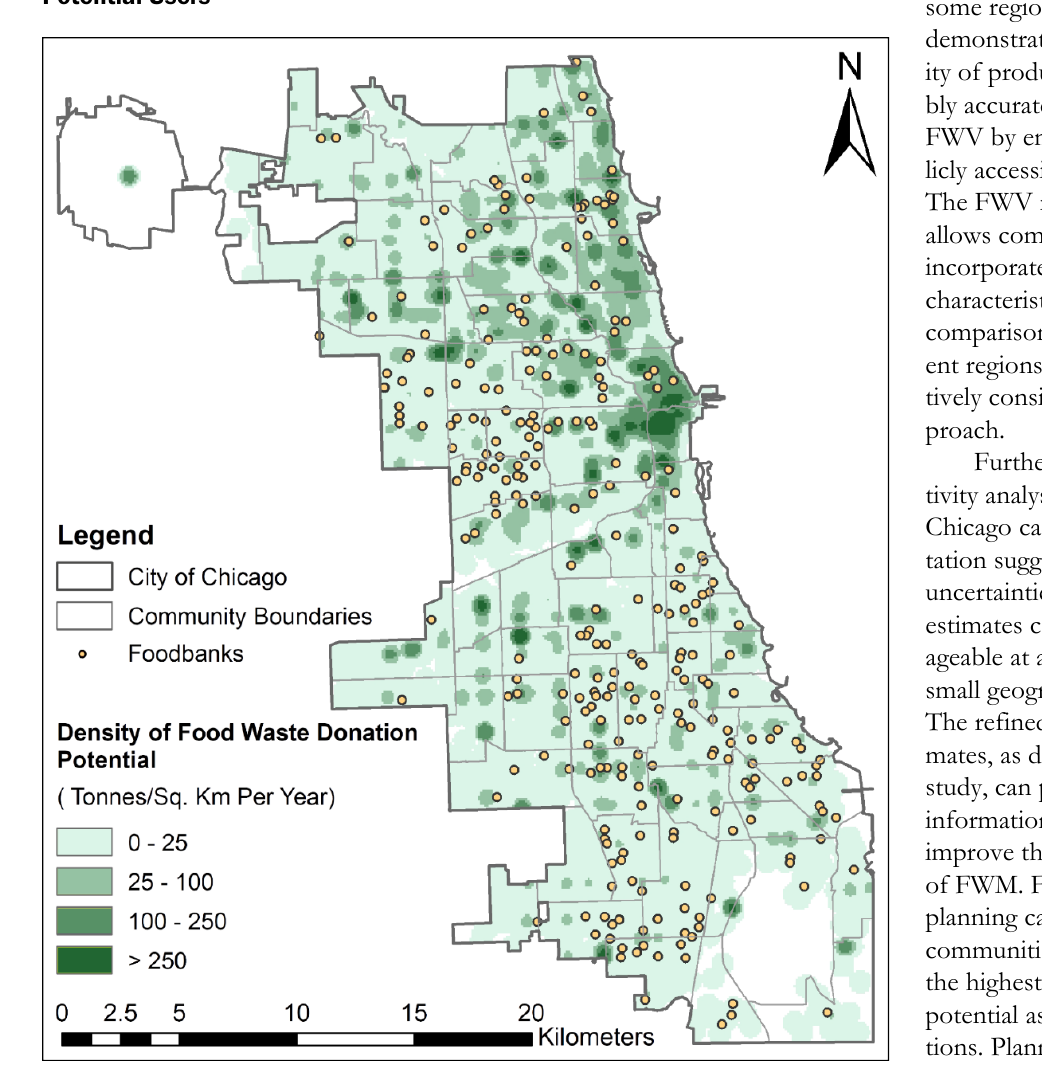
Figure 3. Spatial Distribution of Food Waste Donation Potential and Its Potential